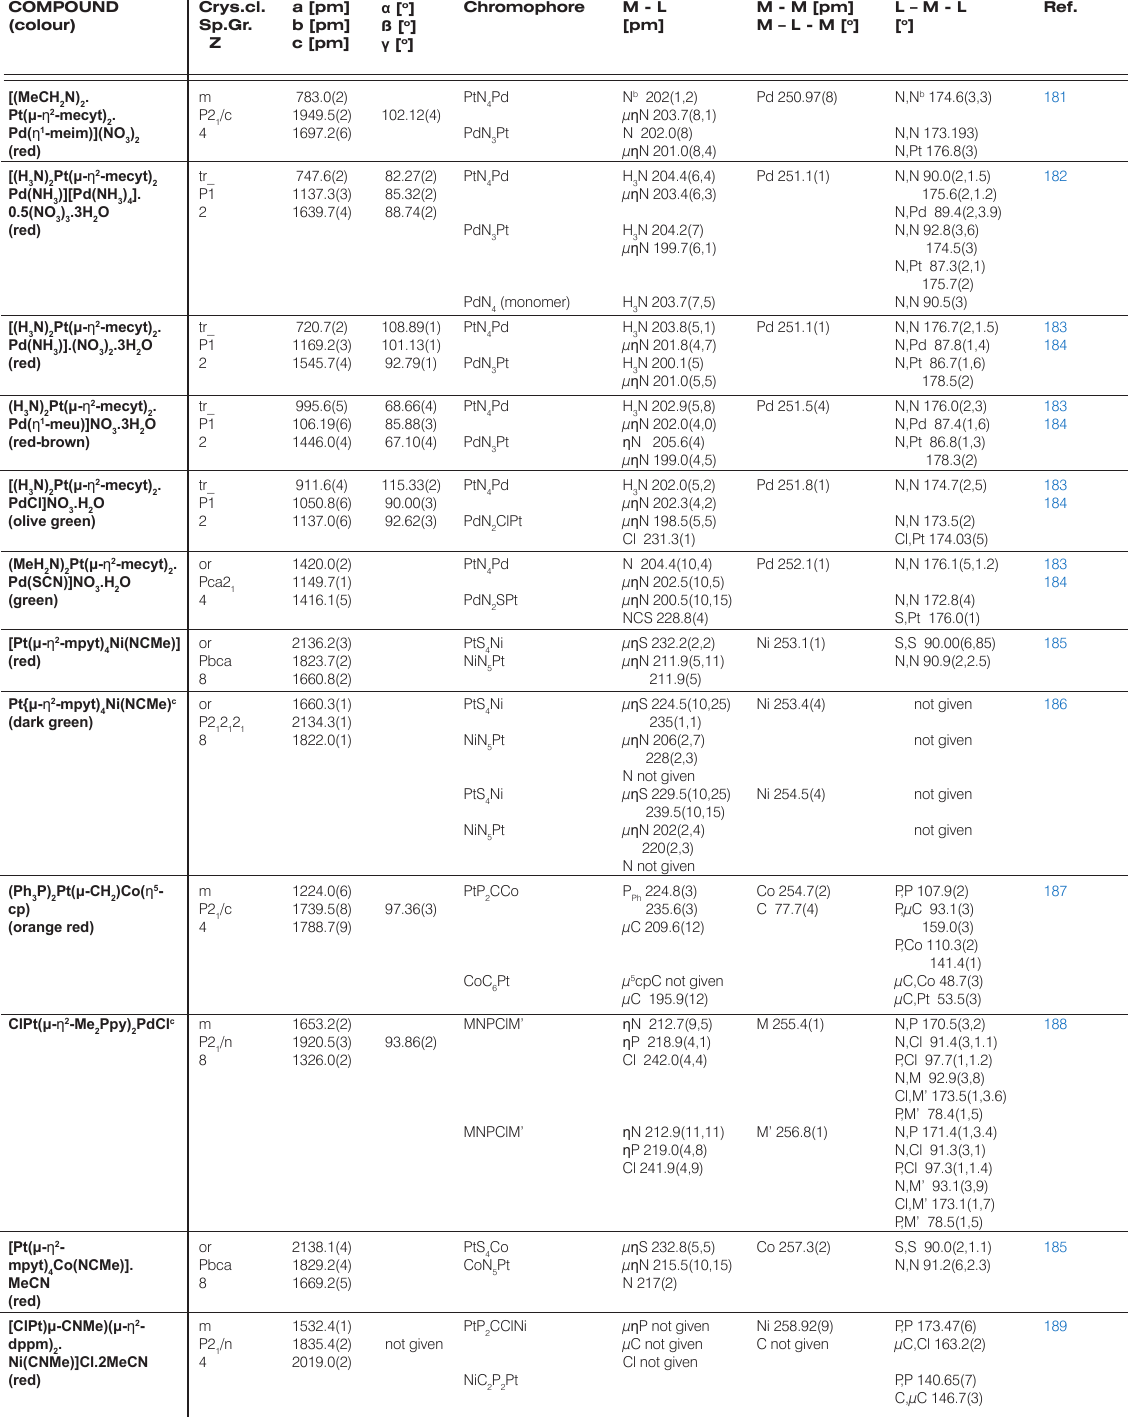
Table 6. Heterobinuclear Platinum Compounds with a Pt-M Bond (M = Co, Rh, Ir, Ni, Pd or Th) a